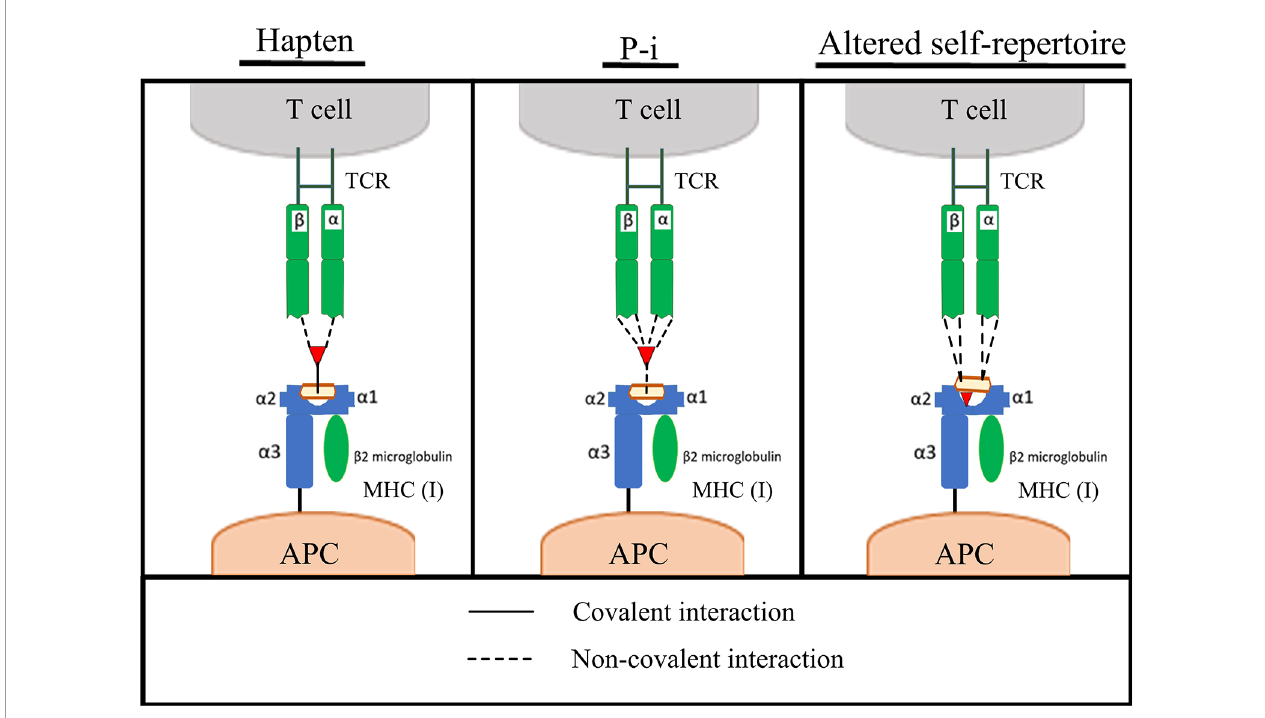
FIGURE 1 | Pathways of T-cell activation by compounds. Left to right; Hapten, pharmacological interact (Pi) and altered self-repertoire hypotheses for the mechanism of antigen presentation in drug hypersensitivity. Adapted from (7,